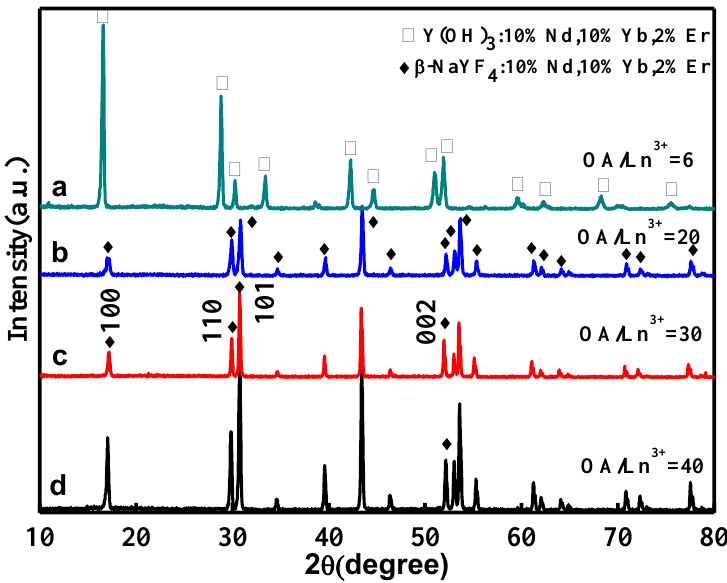
Figure 4. XRD patterns of NaYF